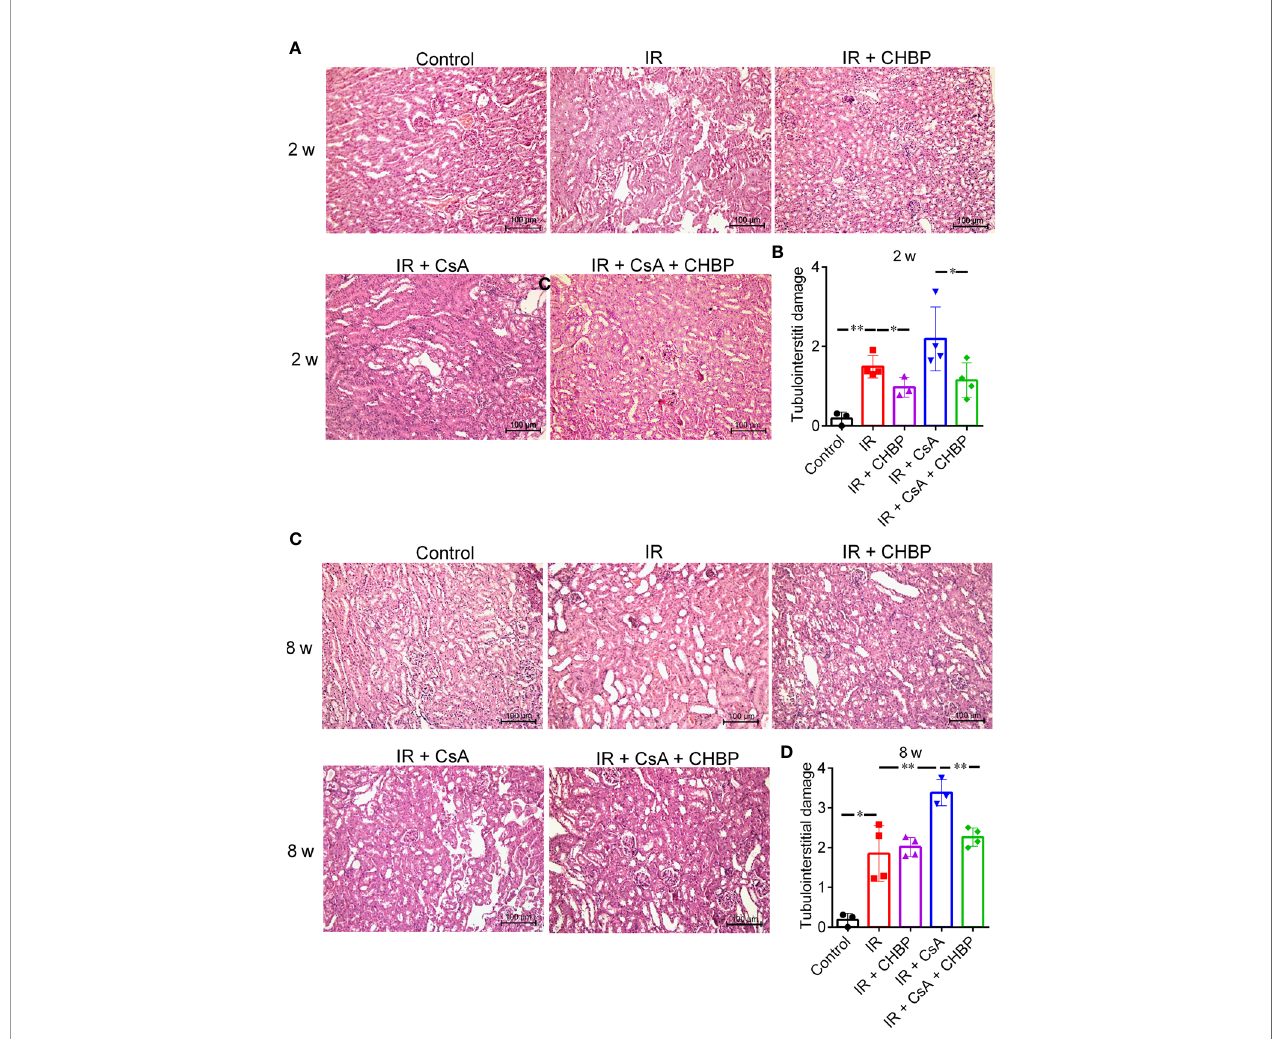
FIGURE 2 | The semi-quantitative score of TID in H&E staining sections. (A, C) Tubular dilation, epithelial cell vacuolation, interstitial expansion with edema or in fl ammation, and cells or cell debris in tubular lumens were mainly seen in IR kidneys. (B) CHBP treatment improved the TID compared with IR and IR + CsA groups at 2 weeks. (D) The score was further increased in the IR + CsA group but reversed by CHBP at 8 weeks. Data were expressed as the mean ± SD of each group (n ≥ 3). * P ≤ 0.05; ** P ≤